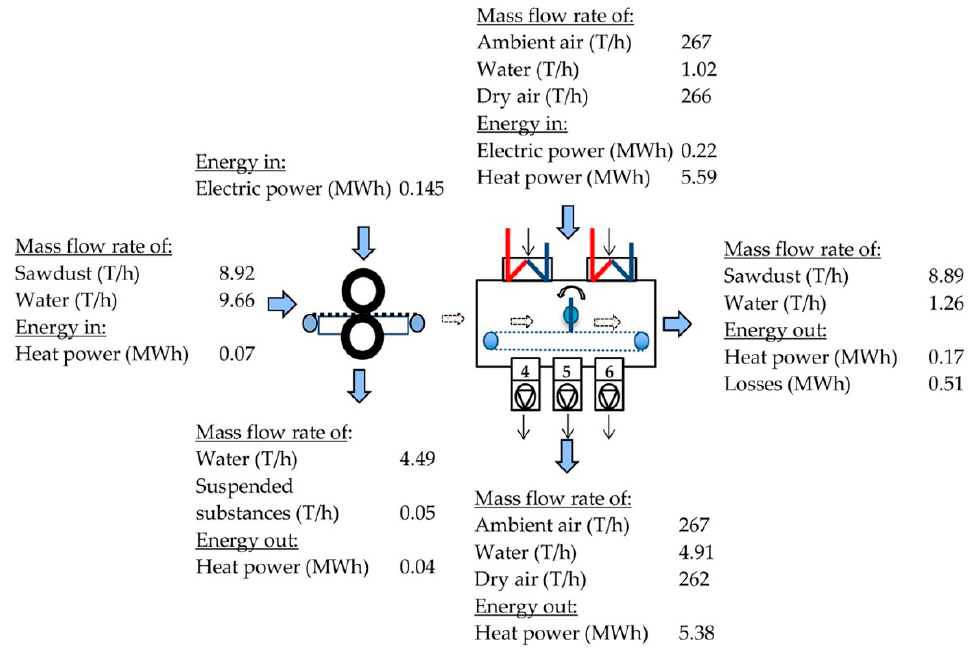
Figure 5. The energy and mass balance for the CDP + PMB.